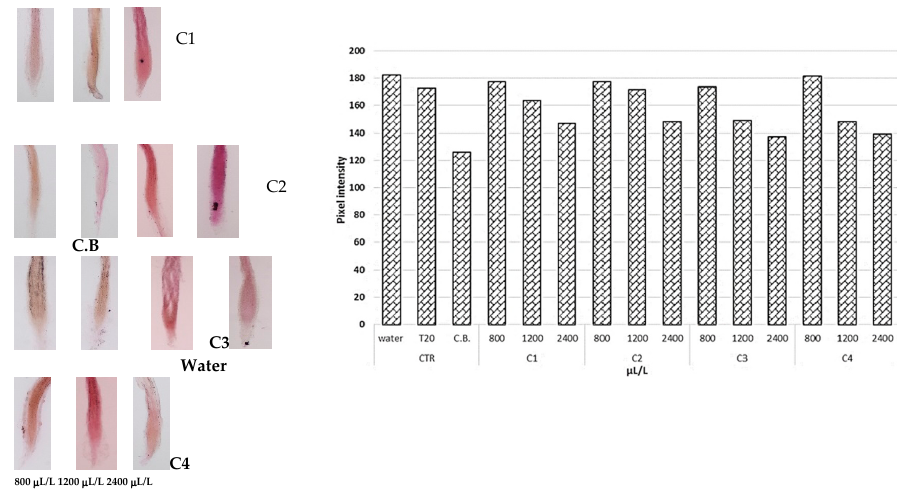
Figure 6. Effect of different chemotype EO concentrations on the intensity of lipid peroxidation in roots of A. retroflexus s tained with Shiff’s (left) and relative pixel intensity (lower intensity indicates a higher staining red intensity and a higher lipid peroxidation) (right). C1 : α -pinene, C2 : camphor, C3 : α -pinene / 1,8-cineole, C4 : α -pinene / camphor / 1,8-cineole. CTR: water, T20: Tween 20 and C.B : Commercial